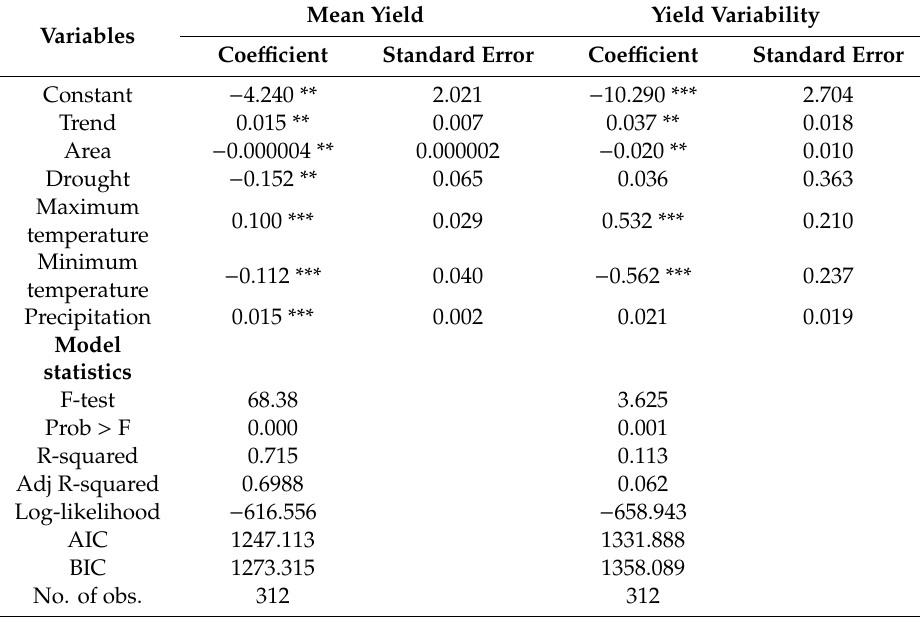
Table 6. Estimates of the impact of climatic variables on average yield and yield variability of dryland wheat, using the Just and Pope linear